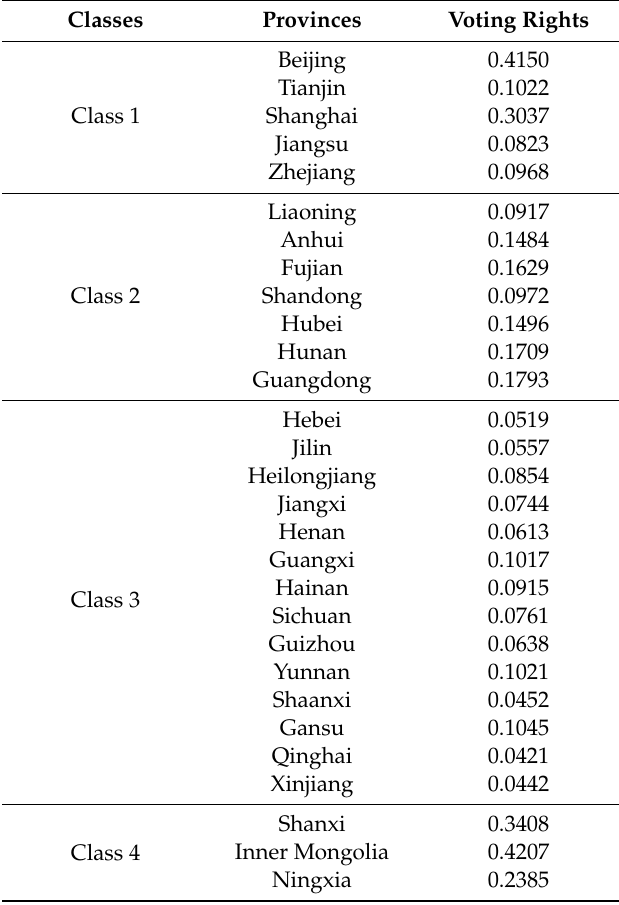
Table 13. The voting right of each